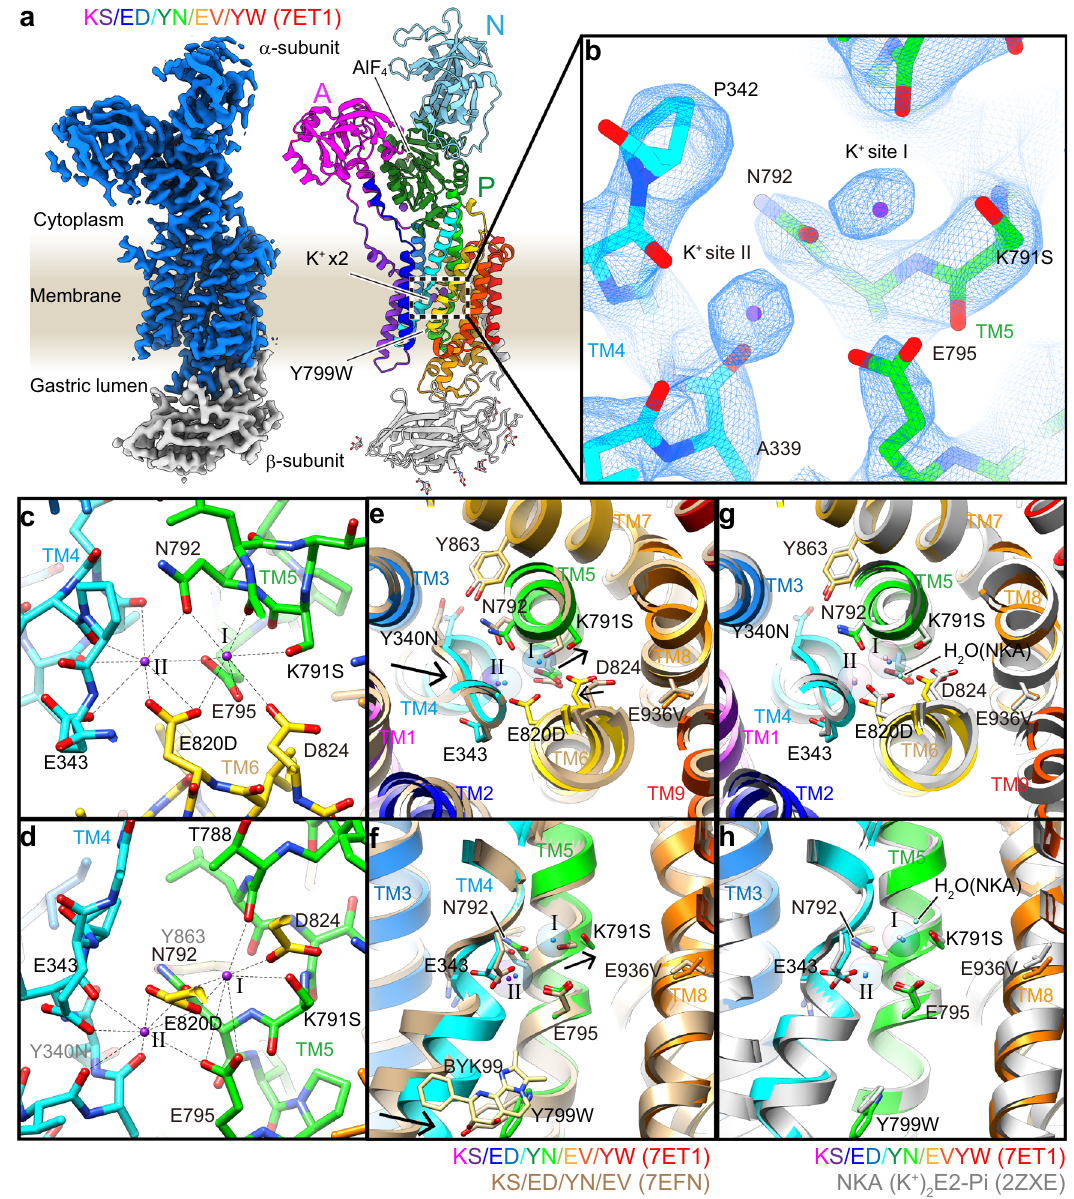
Fig. 5 Cryo-EM structure of the two-K + occluded quintuple mutant. a Cryo-EM density map (left, blue, and gray surface, 5.5 σ ) and amino acid model (right, ribbons, color codes as in Fig. 1) of a quintuple mutant in the K + -occluded E2-AlF state. Key amino acids, phosphate analog AlF, and glycans attached at the β -subunit are shown as sticks. b close-up view of two K + ions occluded at the cation-binding site in the membrane (dotted box in a ). Blue mesh represents EM density map (7 σ ). See Supplementary Movie 3 for more details. c , d K + -coordination in detail. Dotted lines connect K + ions (sites I and II) and coordinating oxygen atoms (see Supplementary Table 5 for more details). e – h structural comparisons between K + -occluded E2-AlF state of the HKA quintuple mutant (color ribbons) and luminal-open BYK99-bound E2BeF state of the HKA quadruple mutant ( e , f wheat ribbons) or NKA wild type in the K + -occluded E2-MgF state ( g , h , gray ribbons, 2ZXE). Black arrows in e , f indicate displacements of structures upon the E2BeF → E2-AlF transition which are found near the luminal portion of TM4, Lys791Ser, and Asp824. Figures are viewed from the cytoplasmic side ( c , e , g ) or along the membrane plane with cytoplasmic side up ( d , f , h ). All structures are aligned based on their TM7-TM10 structures. See Supplementary Movie 4 for more